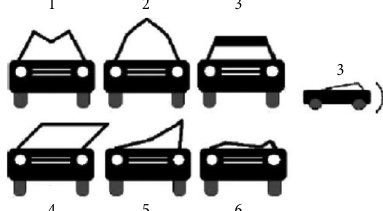
Fig. 1. Main roof crush modes (Gugler, Steffan 2006a, 2006b)